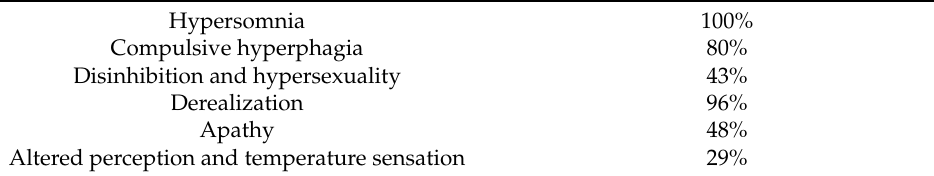
Table 3. Common symptoms in patients with Kleine-Levin syndrome (% of